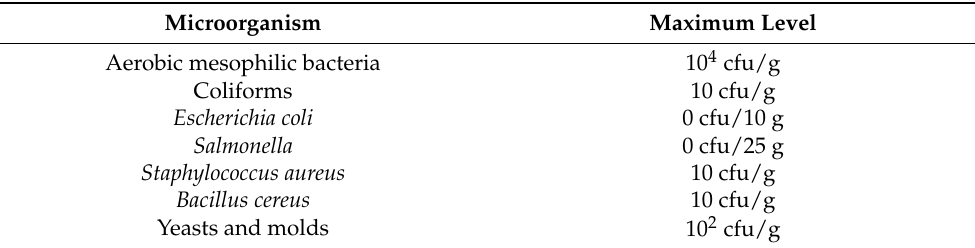
Table 3. Microbiological specifications established by the World Food Program for high energy biscuits